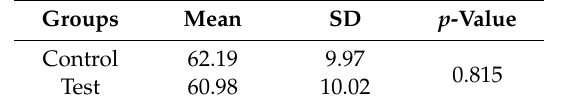
Table 3. Bone volume analysis within regions of interest (ROIs) (%) ( n = 18).